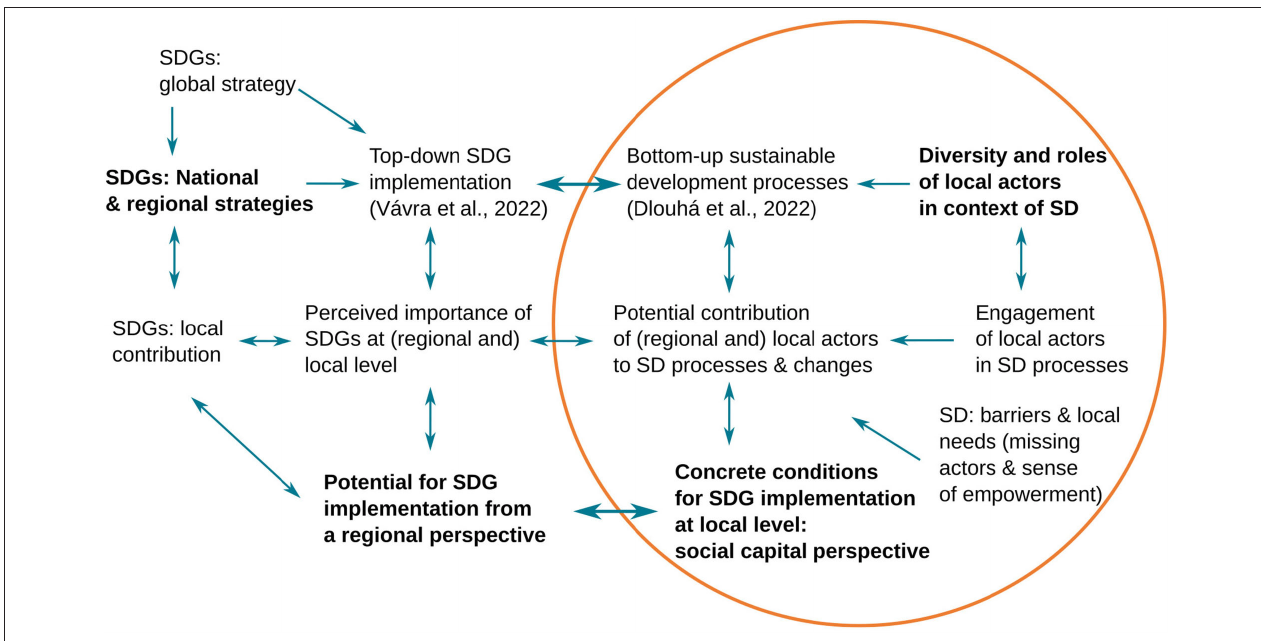
FIGURE 1 | Complementarity of research objectives in the two articles of this special collection: this one (in a circle) and Vávra et al.